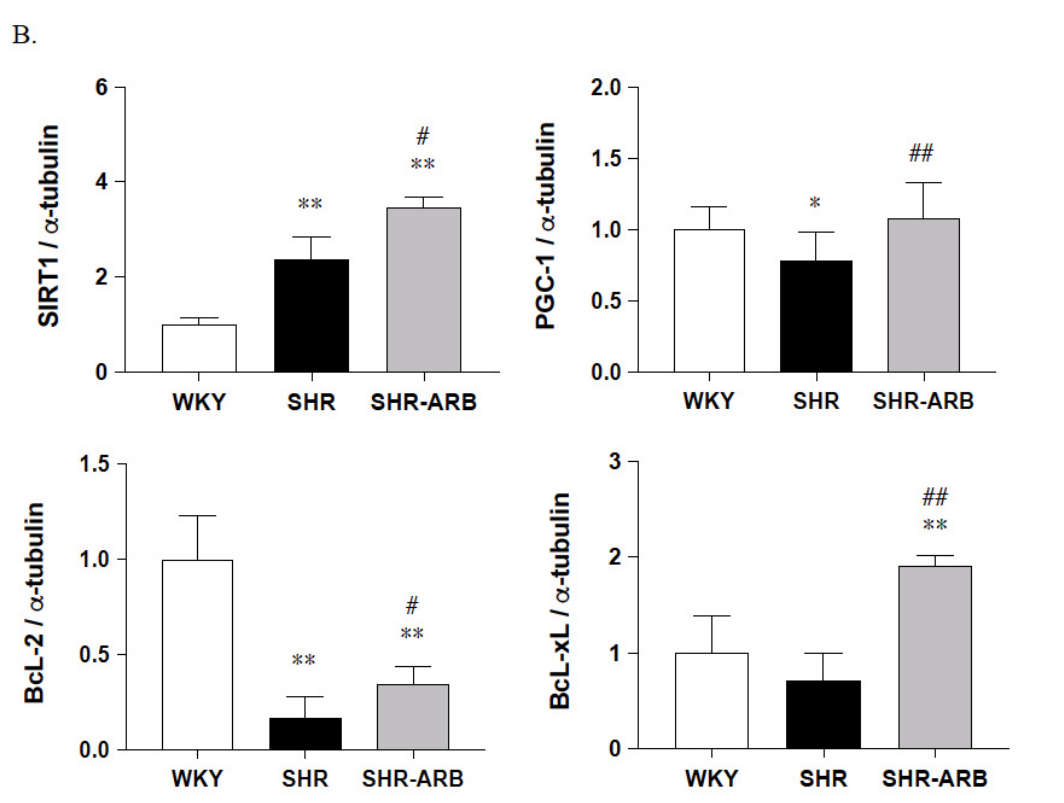
Figure 5. ( A ) The representative protein levels of SIRT1, PGC-1, BcL-2, and BcL-xL extracted from the left ventricles of excised hearts in the normotensive group (WKY), untreated hypertensive group (SHR), and SHR rats with treated irbesartan (SHR-ARB), as measured by Western blot methods. α -Tubulin served as an internal control. ( B ) Bars indicate the relative fold changes of protein levels relative to the Control group in SIRT1, PGC-1, BcL-2, and BcL-xL based on α -Tubulin and show mean ± standard deviation (n = 8;8;8). * p < 0.05, ** p < 0.01: significant differences from the Control group. # p < 0.05, ## p < 0.01 indicates significant differences between the SHR group and the SHR-ARB group.